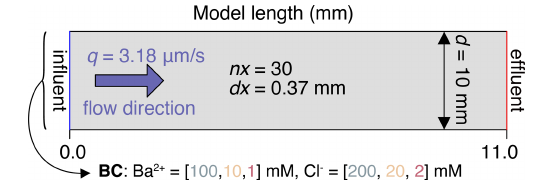
= 0 . 56, ϕ = 0 . 0, SSA = BaSO 4 4 = 0 . 621mM, 4